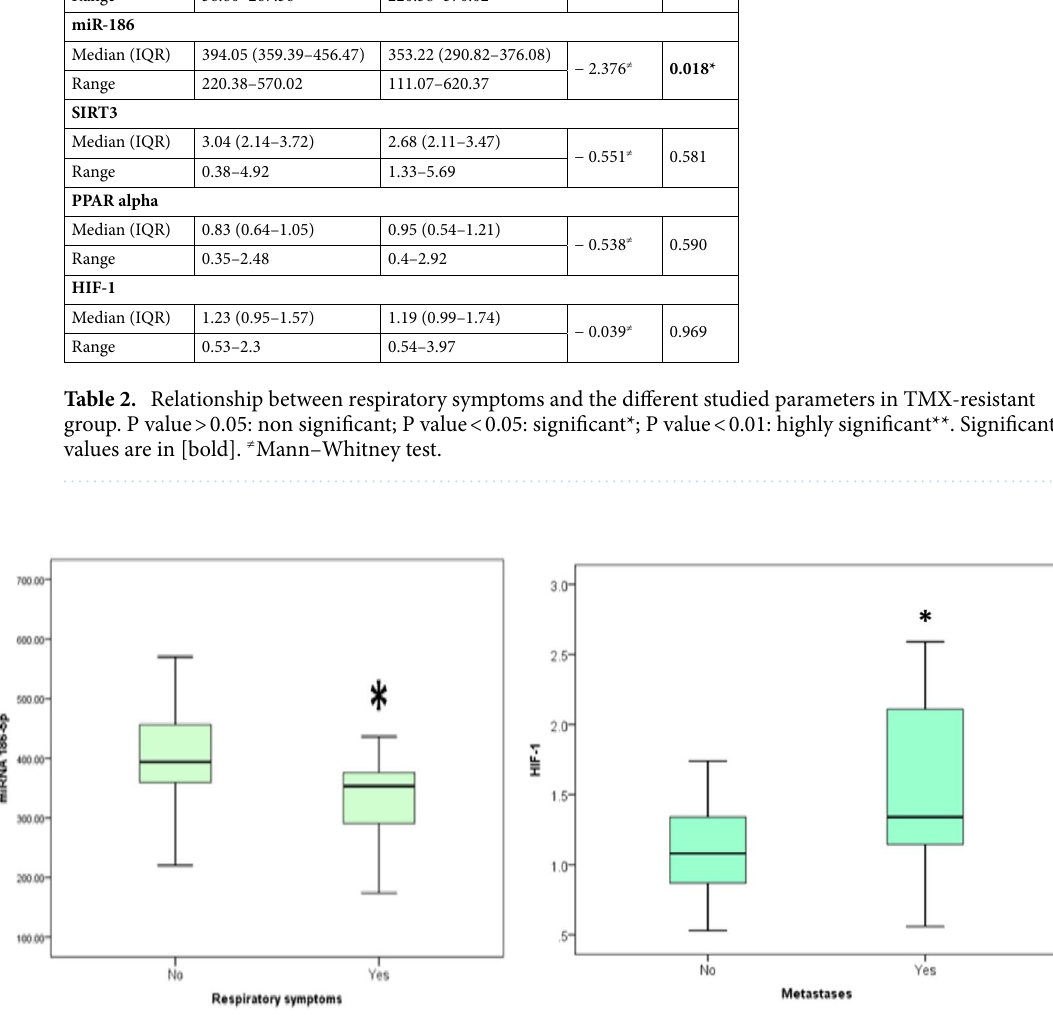
Figure 2. The boxplot (median and IQR) for the plasma miR‑186 levels with TMX‑resistant patients having respiratory symptoms and for the serum HIF‑1α levels with TMX‑resistant patients having metastases. In this figure, Mann–Whitney test was used to compare two independent groups with quantitative data and non‑ parametric distribution. This box plot figure shows a significant negative association between miR‑186 and respiratory symptoms at test value of − 2.376 and P value of 0.018. It also shows a significant positive association between HIF‑1 α and metastases at test value of − 2.224 and P value of 0.026. Logistic regression analysis showed that there was statistically significant association found between miR‑186 ≤ 376.08 and respiratory symptoms with P value = 0.005 and OR (95% CI) of 8.667 (1.904–39.442), where respiratory symptoms rate increase as miR‑186 decreases in TMX resistant patients. It also showed that there was statistically significant association found between HIF‑1α > 1.12 and metastases with P value = 0.009 and OR (95% CI) of 6.171 (1.583–24.054), where metastases rate increase as HIF‑1α increases in TMX resistant